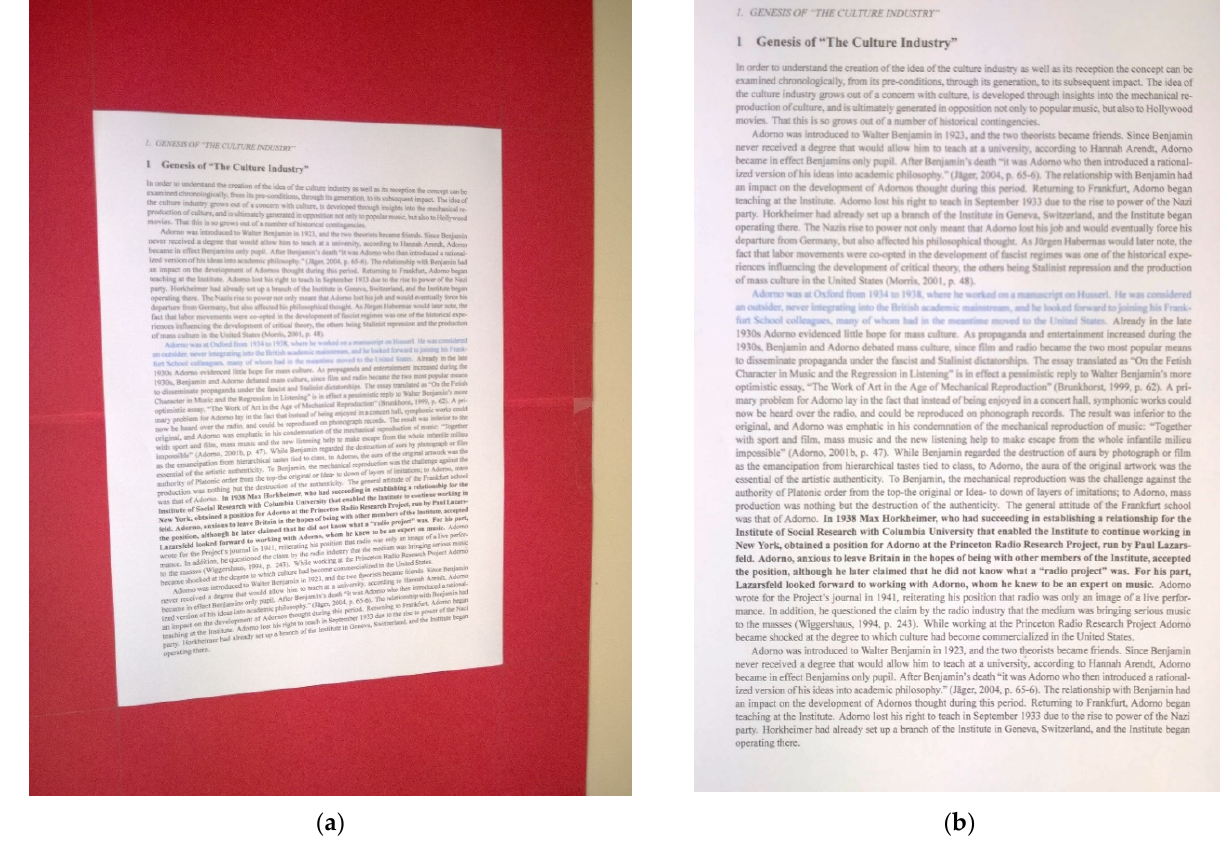
Figure 12. The most improved image of document D1 of the SmartDoc dataset: ( a ) original version resulting in an OCR accuracy of 25%; ( b ) cleaned version with an OCR accuracy of 94%.